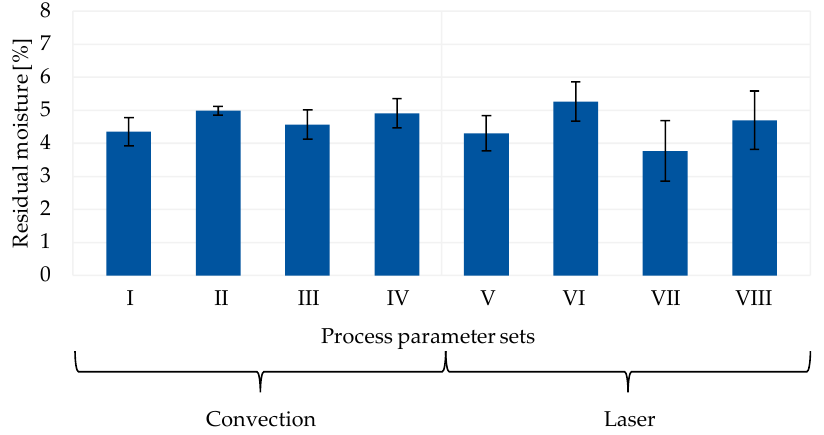
Figure 6. Residual moisture of convection- and laser-dried anodes with 10 w solid -% silicon content. It can be obtained that all samples exhibit a residual moisture between 3.7% and 5.2%.